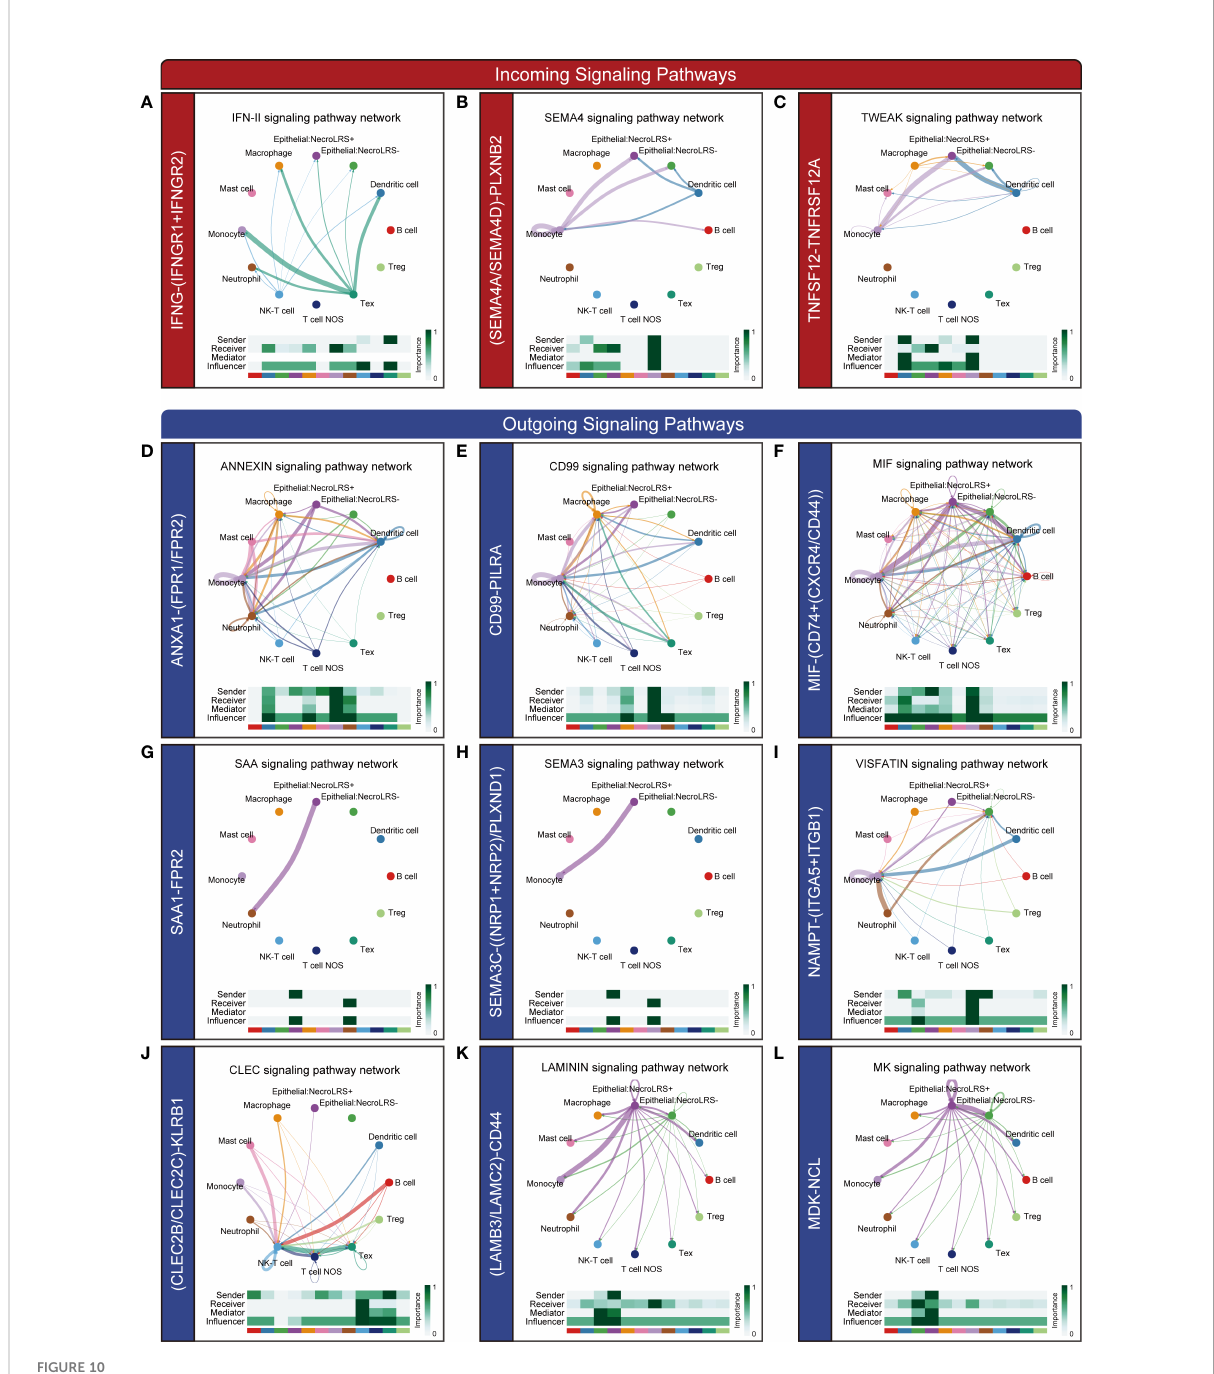
FIGURE 10 Novel ligand-receptor pairs differ between NecroLRS-High cells and immune cells. Ligand-receptor pairs in the incoming (A – C) and outgoing (D – L) interaction of NecroLRS-High cells with immune